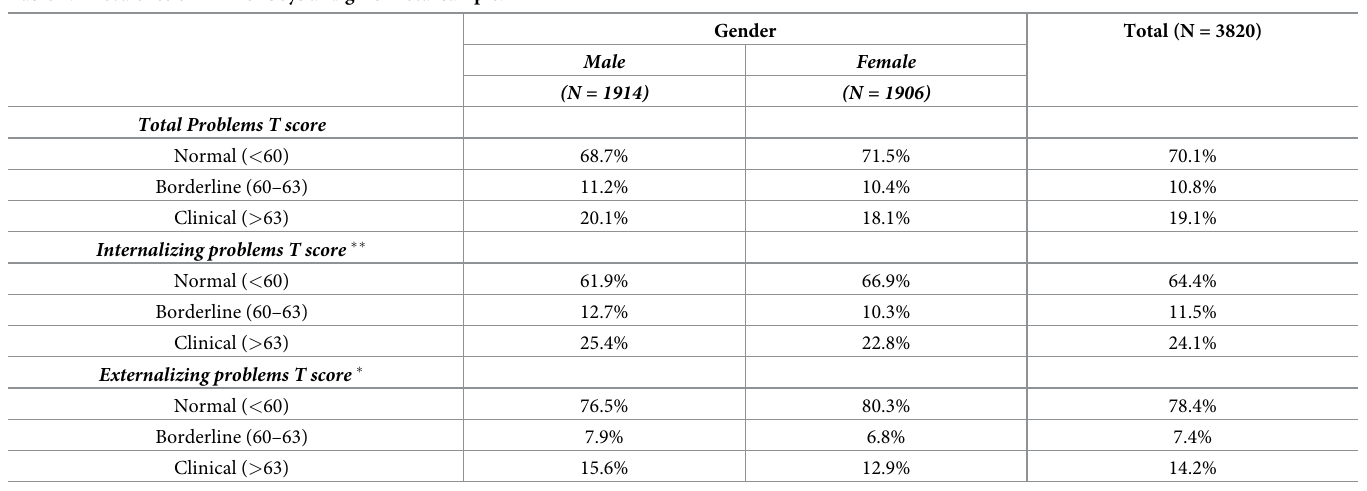
Table 2. Prevalence of EBP for boys and girls–Total sample.